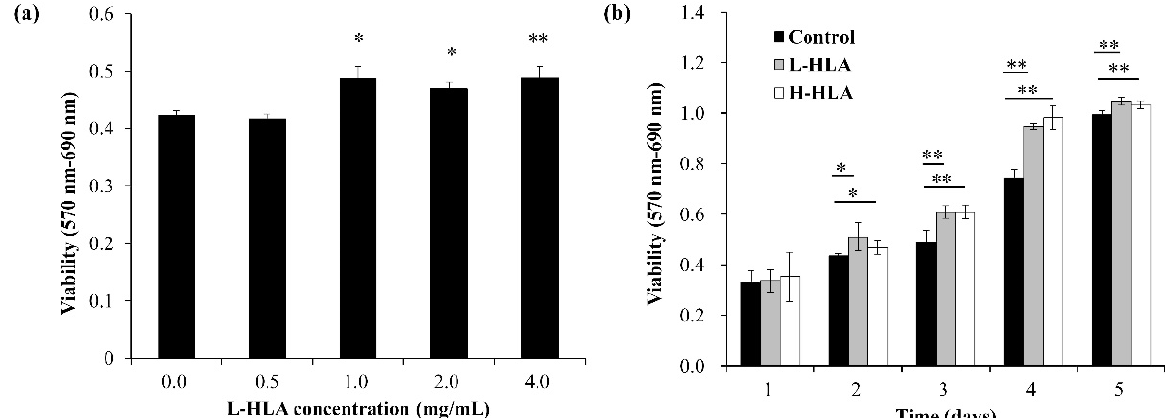
Figure 4. ( a ) L-HLA at concentrations above 1.0 mg/mL increased DPSC cell viability in serum-free medium. ( b ) DPSC cells treated with L-HLA and H-HLA for 5 days. Data are presented as mean ± standard error in at least three independent experiments. Significance is indicated as * ( p < 0.05) and ** ( p < 0.01).